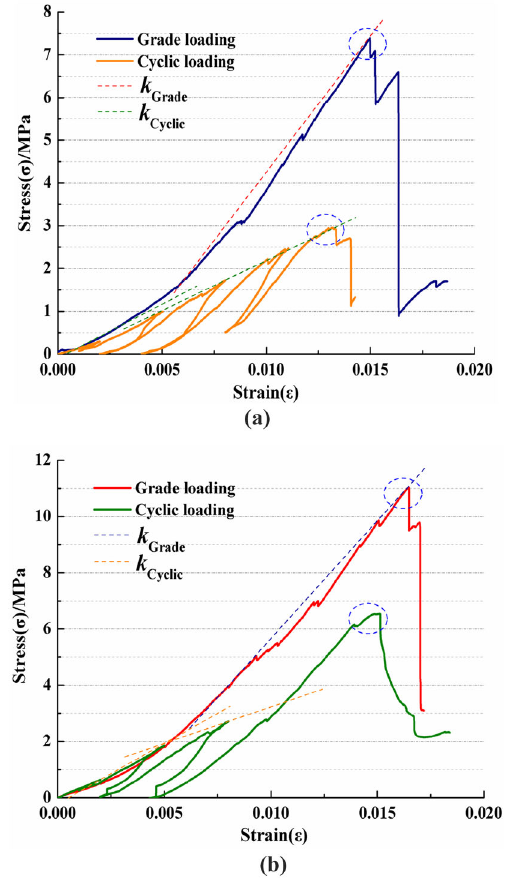
Fig. 6 Stress-strain curve. a group I: load direction parallel to bedding, b group II: load direction perpendicular to bedding